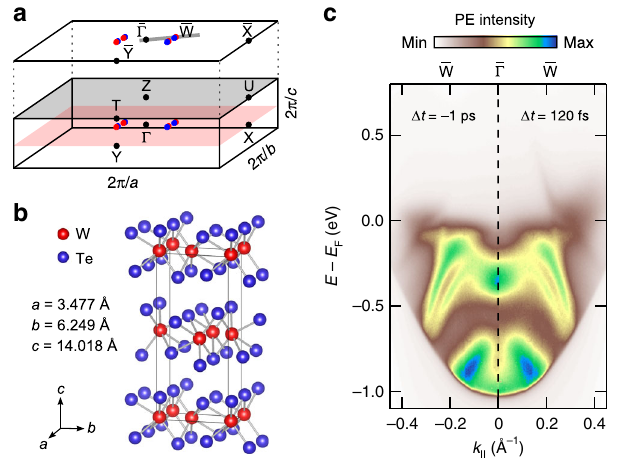
Fig. 1 Crystal and electronic structure of Td -WTe 2 . a 3D Brillouin zone and its projection onto the (001) surface. Blue and red dots mark the approximate positions of the Weyl points as predicted in ref. 8 . The gray line crossing Γ and W indicates the momentum cut investigated in the present TRARPES study. b Orthorhombic unit cell with experimental lattice constants at T = 113 K 44 . c ARPES intensity maps in Γ – W direction before ( Δ t = − 1 ps) and after ( Δ t = 120 fs) excitation with 827 nm pump